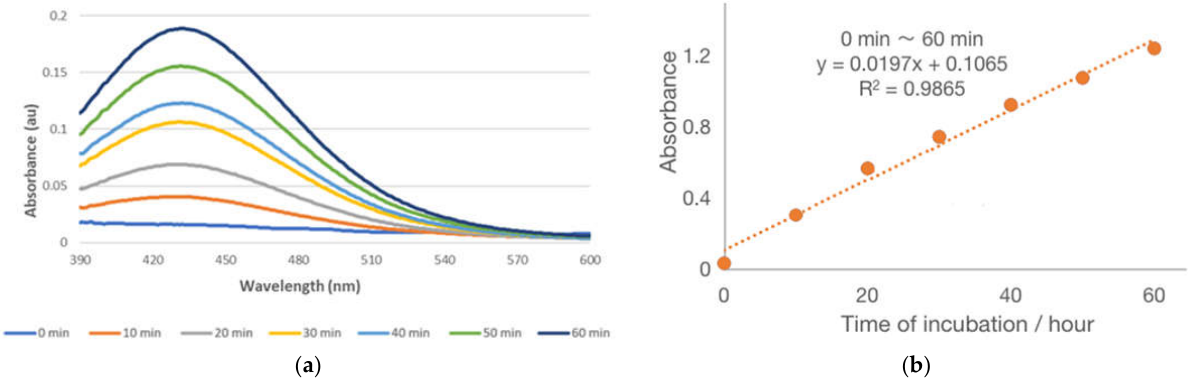
Figure 1. ( a ) UV–visible spectra recording the hydroxylation of NPBG at 10 min intervals of